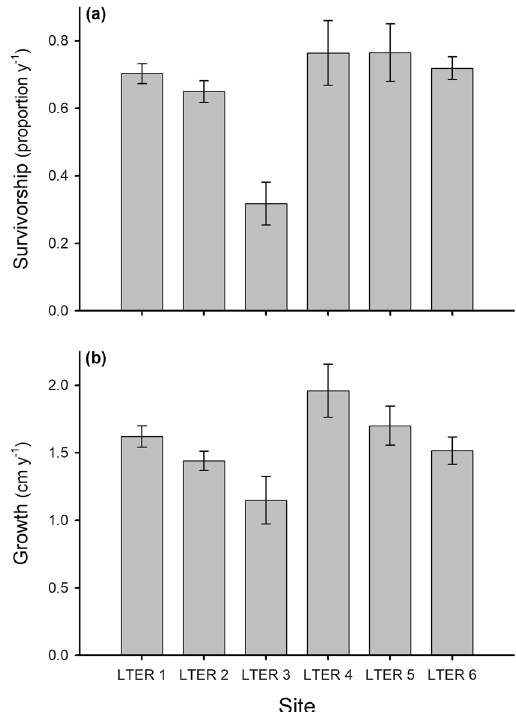
Figure 4. Variation among sites around Moorea in annual mean ( ± SE) survivorship ( a ) and mean ( ± SE) growth rates ( b ) of Pocillopora recruits. Variation in survivorship and growth did not match the spatial pattern in return of cover of live coral; these mechanisms appear insufficient to explain the observed variation among sites in return of